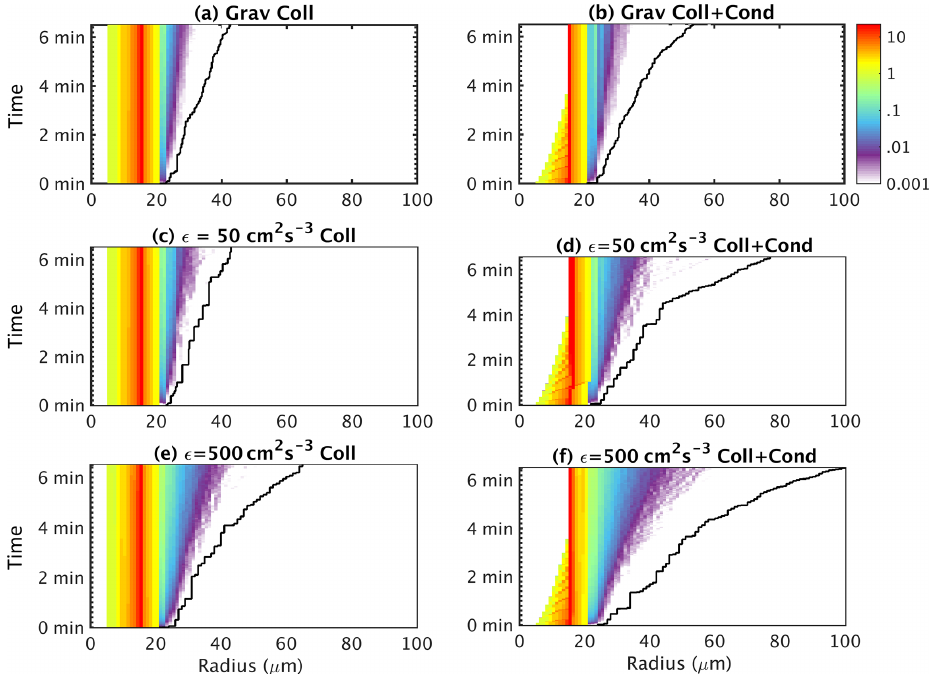
Figure 2. The time evolution of the DSD in the collision-only (Coll) experiments ( a, c, e ) and the collision–condensation (Coll + Cond) experiments ( b, d, f ). Results from the purely gravitational case (first row), weak turbulence ( (cid:15) = 50cm 2 s − 3 , c, d ), and strong turbulence ( (cid:15) = 500cm 2 s − 3 , e, f ) are demonstrated. The solid black curve indicates the largest droplet of the entire domain. The droplet number concentration (cm − 3 ) on each size bin (bin width = 1µm) is displayed in color using a logarithmic scaling shown in the color bar. Droplet number concentrations below 0.001cm − 3 are treated as statistical uncertainty and thus are given no color in the